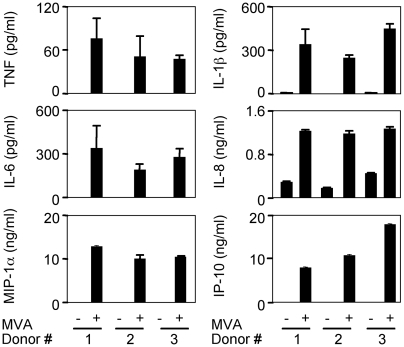
TNF, IL-1β, IL-6, IL-8, MIP-1α and IP-10 release by human whole blood exposed to MVA.Whole blood from 3 healthy volunteers (#1, 2 and 3) was incubated for 24 h with (+) or without (−) MVA (MOI 1) in triplicates. Cell-free supernatants were collected to quantify the concentrations of TNF, IL-1β, IL-6, IL-8, MIP-1α and IP-10. Data are means±SD of triplicate samples from one experiment. MVA significantly increased cytokine production (p<0.05 for all conditions).